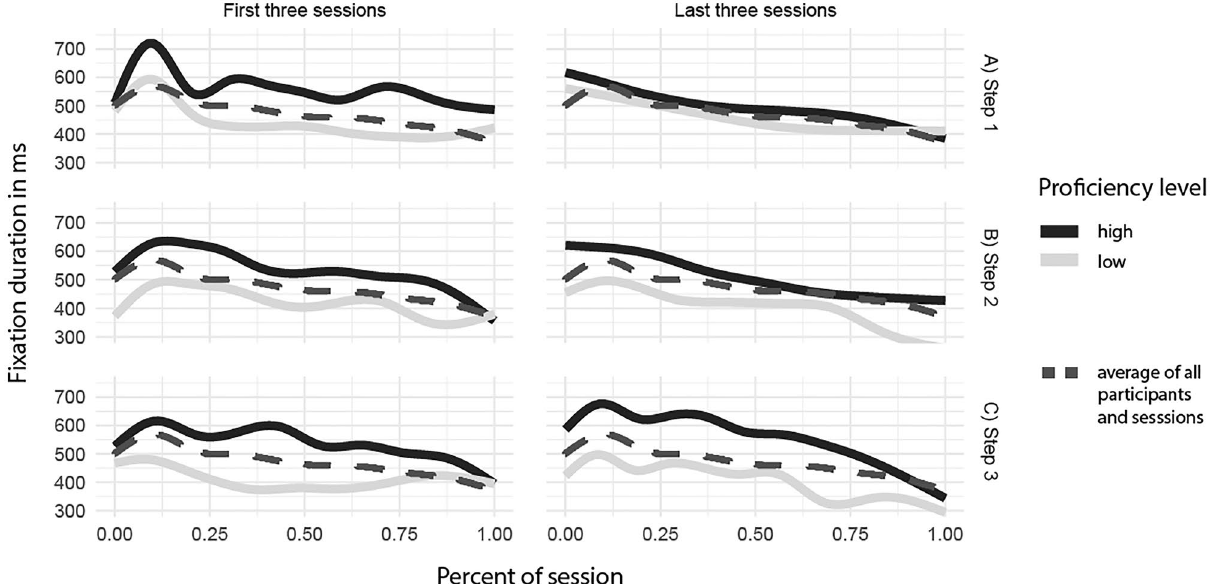
Figure 5. Development of fixation duration within first and last three sessions per step. Time is represented as percentage. The dotted line depicts the overall development averaged over all participants and sessions.